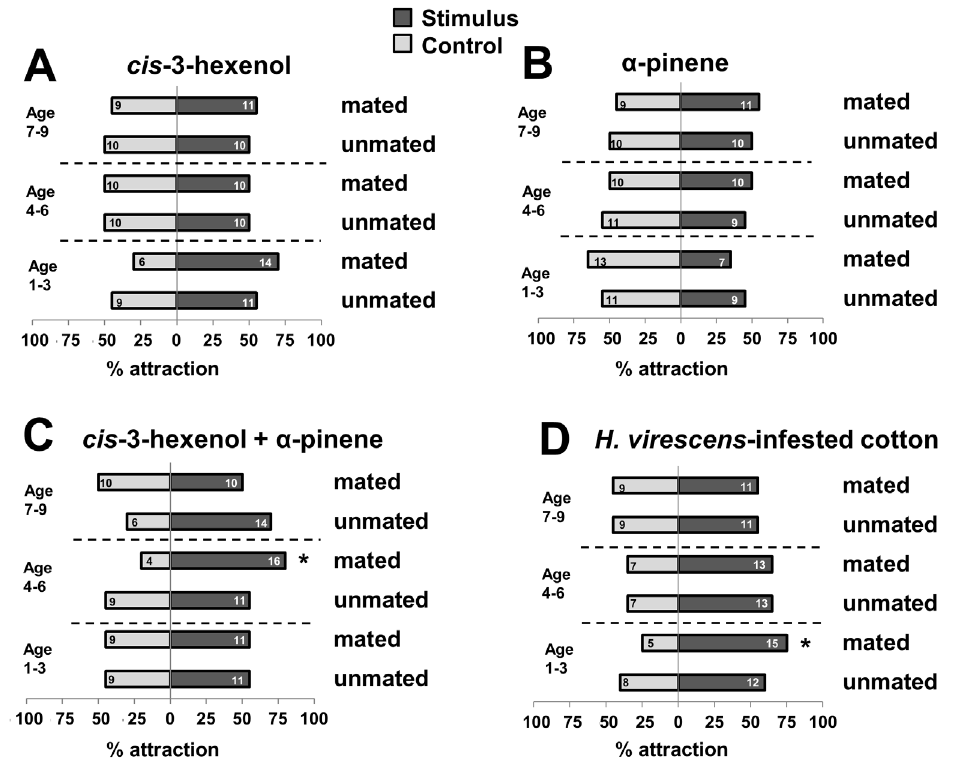
Figure 1. Effect of age and mating status on the attraction of female Microplitis croceipes to four host-related plant odors in Y-tube olfactometer bioassays. Bars represent percentage of mated and unmated parasitoids of ages 1–3, 4–6, and 7–9 d-old when given a choice between hexane (solvent control) and synthetic compounds cis -3-hexenol ( A ), α -pinene ( B ), a 50/50 v/v binary mixture of cis -3- hexenol and α -pinene ( C ), and a choice between control jar (with no plant) and Heliothis virescens -infested cotton ( D ). Synthetic compounds were formulated in hexane at 1 µg/µl and presented as 10 µl samples (10 µg dose). Thirty 2 nd –3 rd instar larvae of H. virescens were allowed to infest cotton plants for 24 h before bioassays. N = 20 responding parasitoids per choice test. Numbers in the bars indicate actual number of responding individuals that chose each arm of the olfactometer. Asterisk (*) indicates significant deviation of parasitoid responses from a 50:50 (stimulus: control) distribution ( χ 2 goodness of fit test, P <